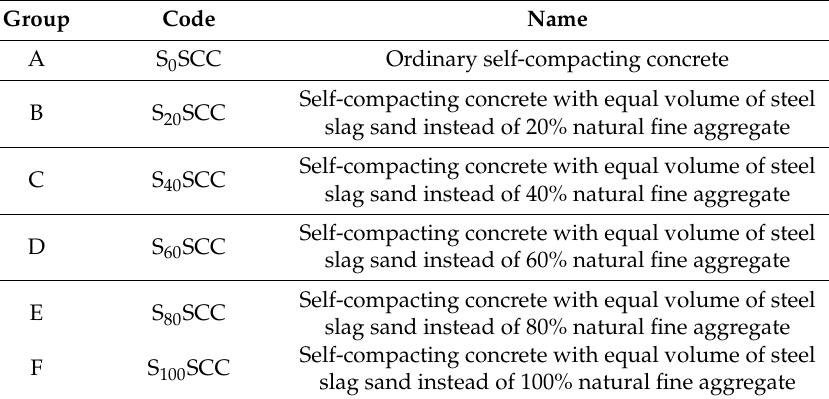
Table 8. Substitution of steel slag mixture in di ff erent